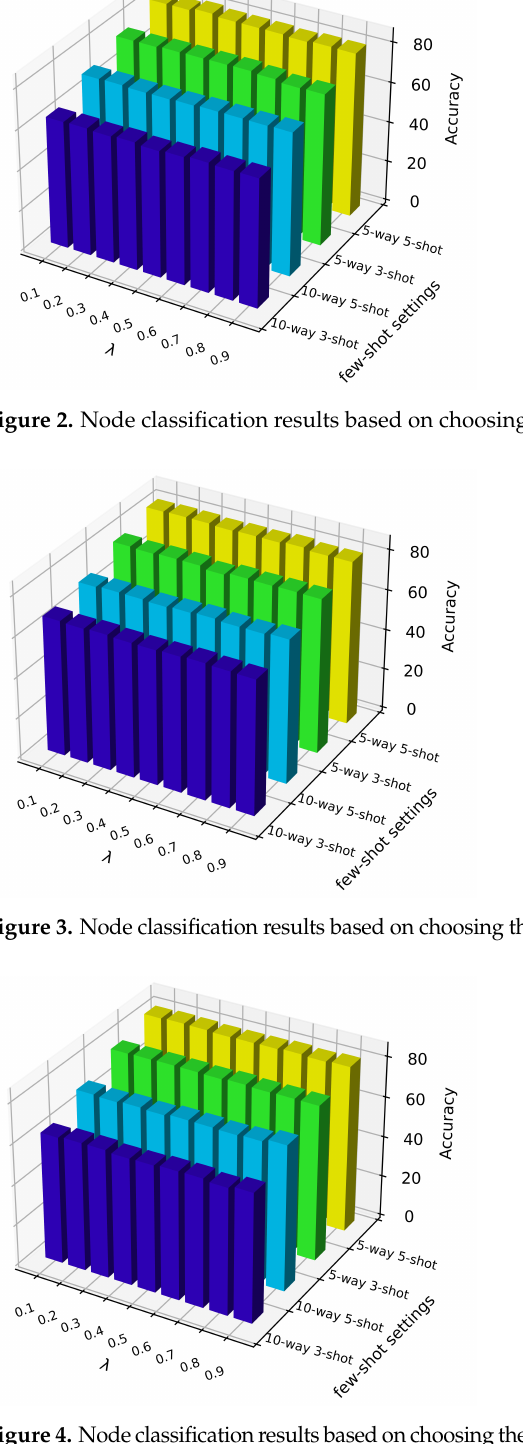
Figure 4. Node classification results based on choosing the balancing parameter λ on